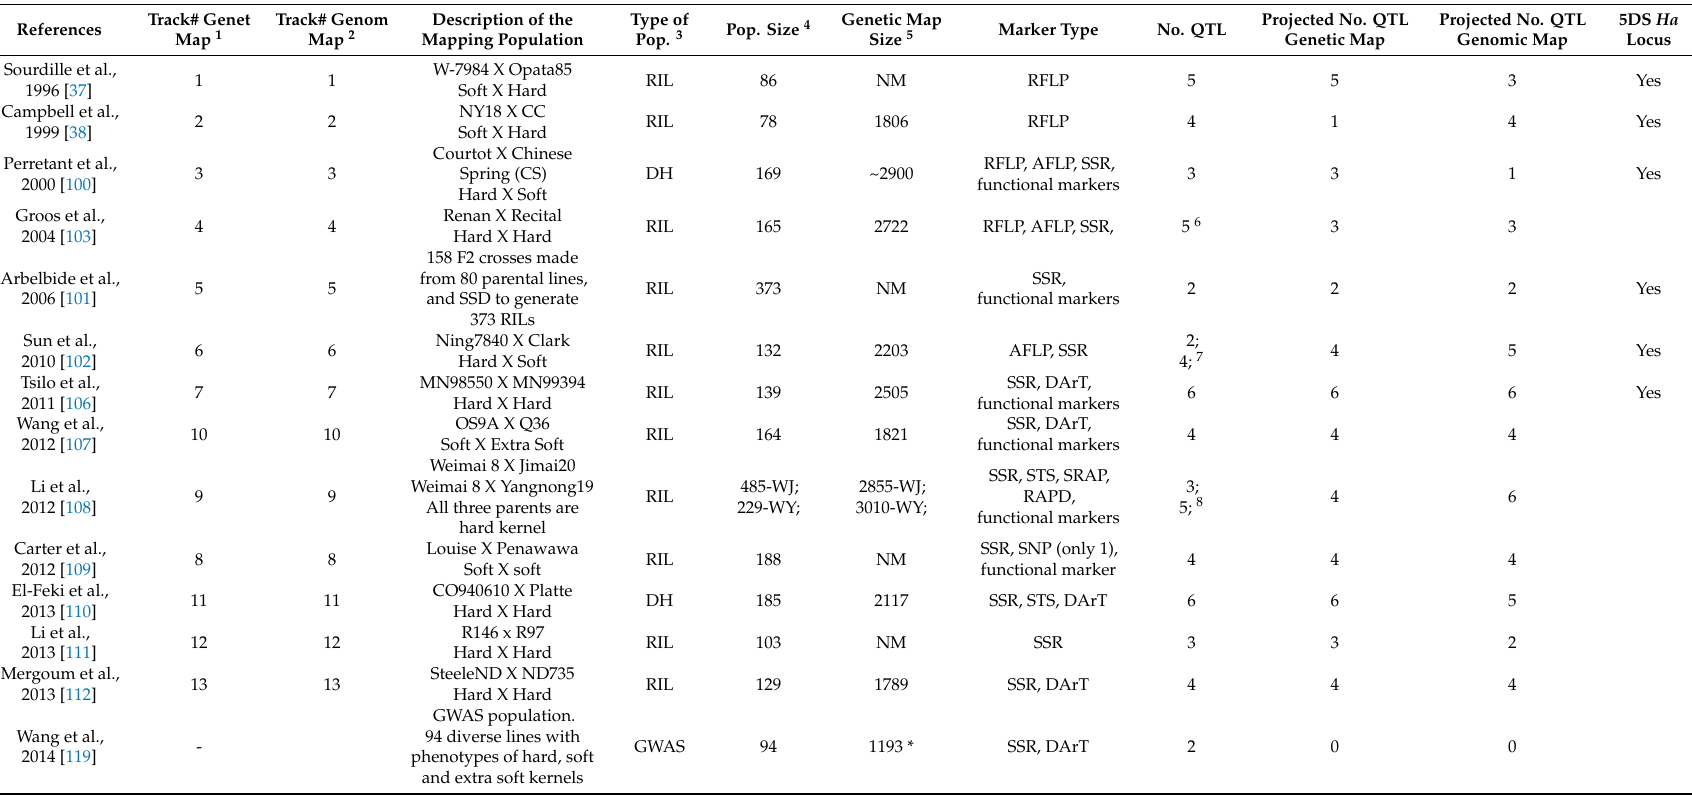
Table 1. Summary of QTL studies included in this